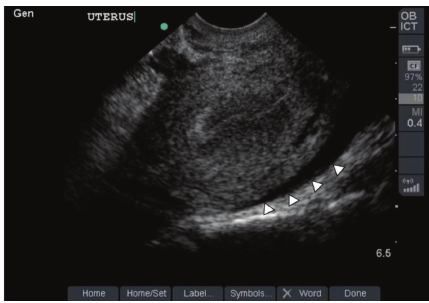
Figure 1: Utilizing a 5–8MHz Sonosite intracavitary transducer, an empty uterus is noted. Posterior to the uterus, there is a region of hypoechoic fluid visualized (arrowheads).